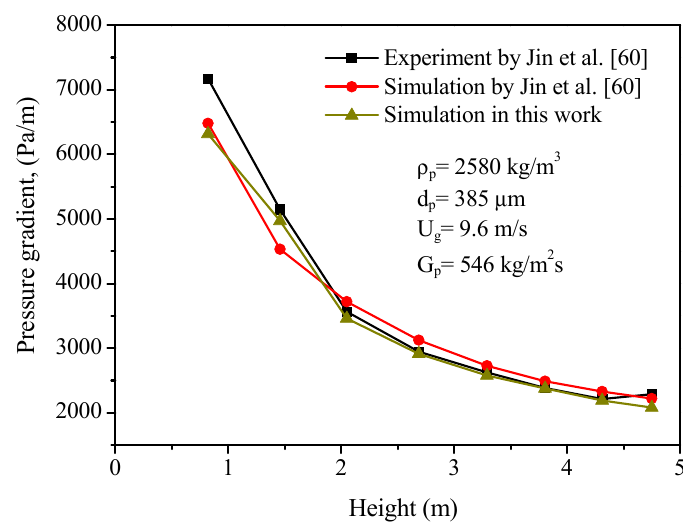
Figure 2. Comparisons of axial pressure gradient profiles between the experiment and simulation.